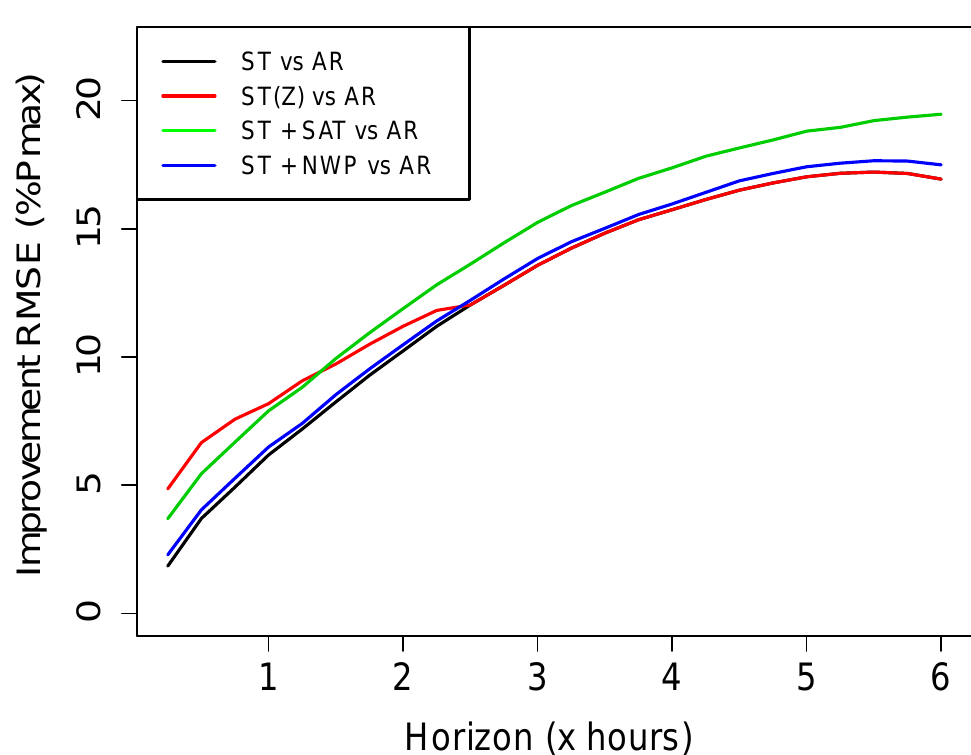
Figure 8. Comparison of the average (over all power plants) forecasting performances of the models. The time step is 15